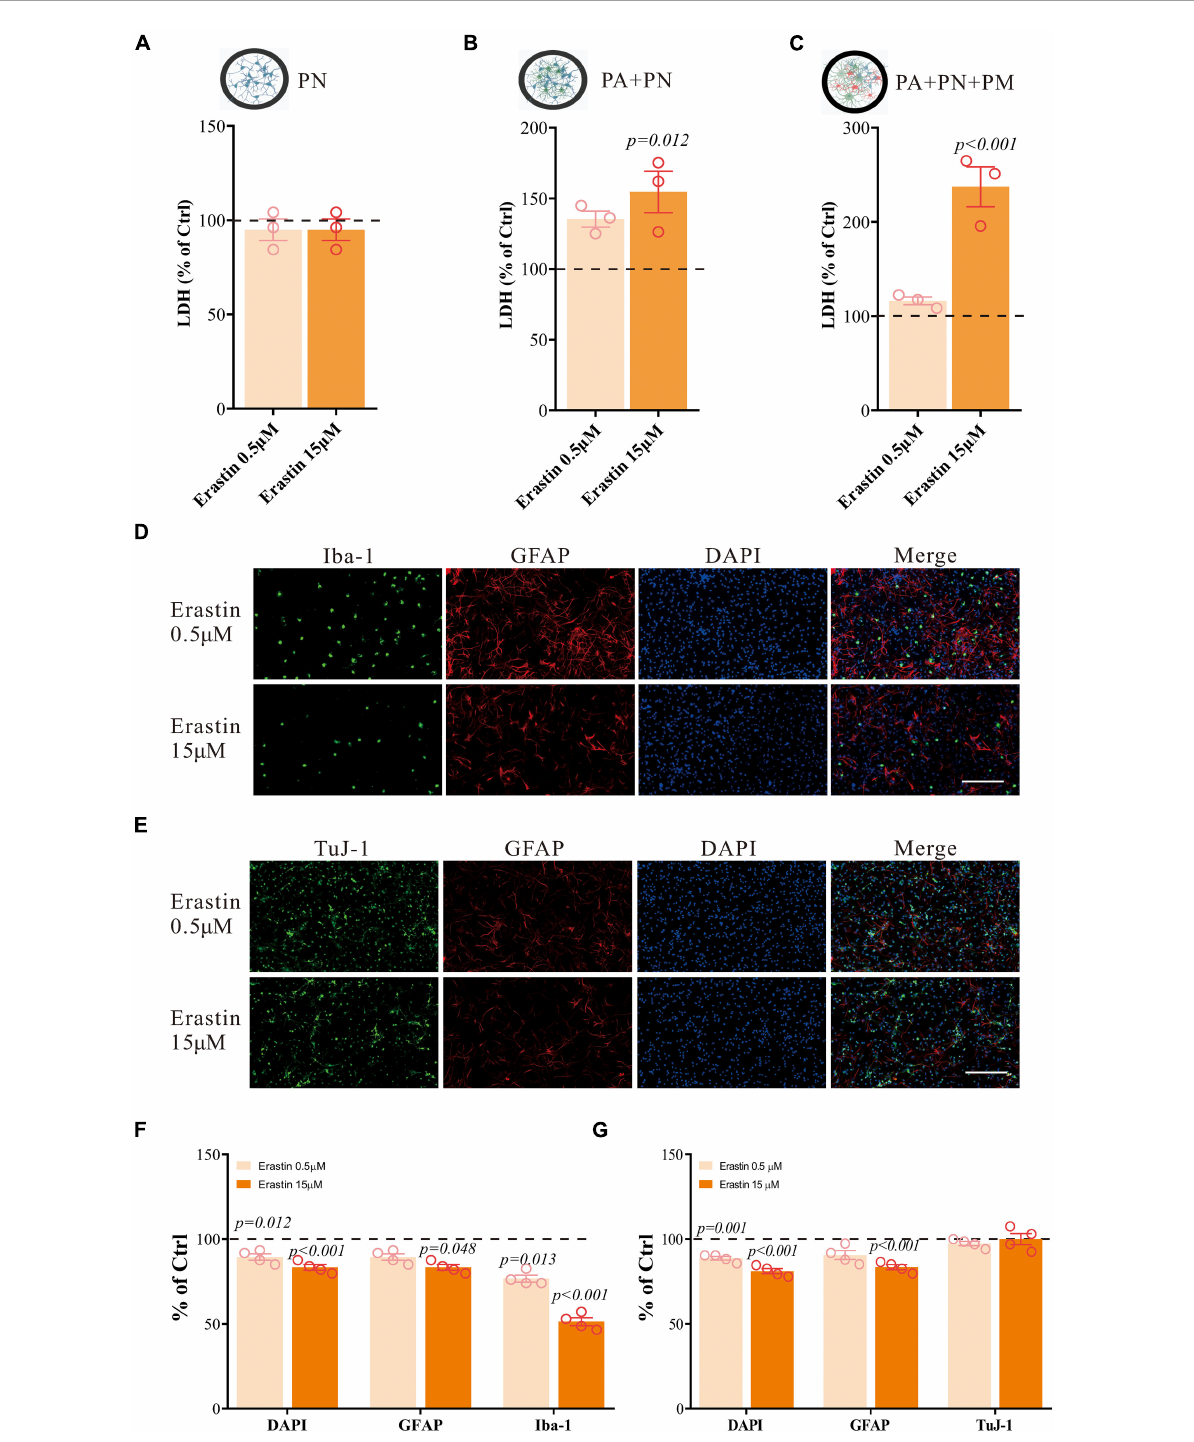
FIGURE5 Erastin induces primary brain cell death in co/tri-culture system. (A–C) Cell viability detected by LDH in PN monoculture (A) , PA/PN co-culture (B) , and PA/PN/PM tri-culture system (C) after erastin treatment for 24 h. (D–G) Brain cells in the tri-culture system were stained with Iba-1 (green), TuJ-1 (green), GFAP (red) and DAPI (blue) after erastin treatment for 24 h (D,E) . The quantification of the proportion of DAPI, GFAP, Iba-1 and TuJ-1 positive cells in the tri-culture system (F,G) . Data are means ± SEM, N = 4, scale bar = 200 µ m. One-way ANOVA with post hoc Tukey test was